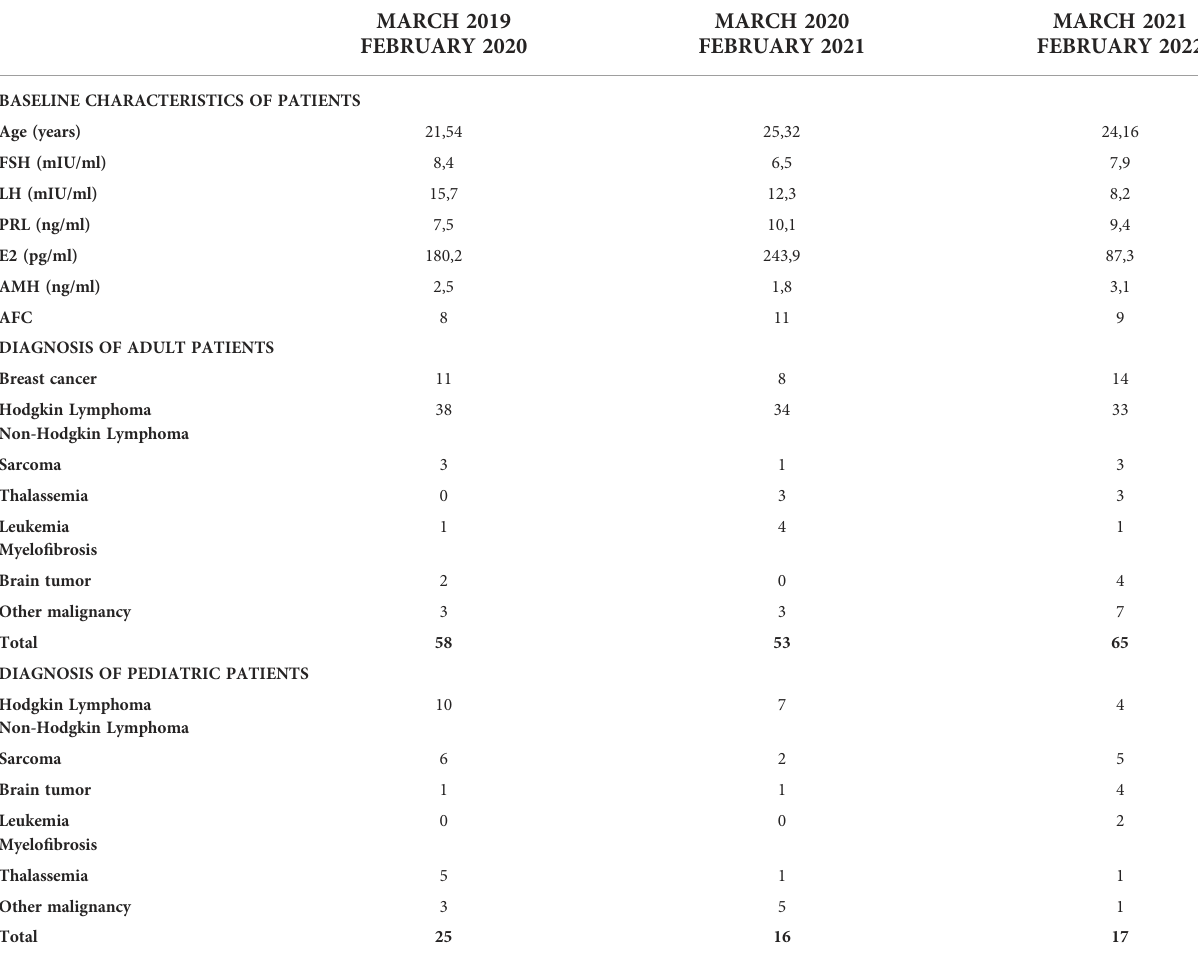
TABLE 2 Baseline characteristics of the patients from March 2019 to March